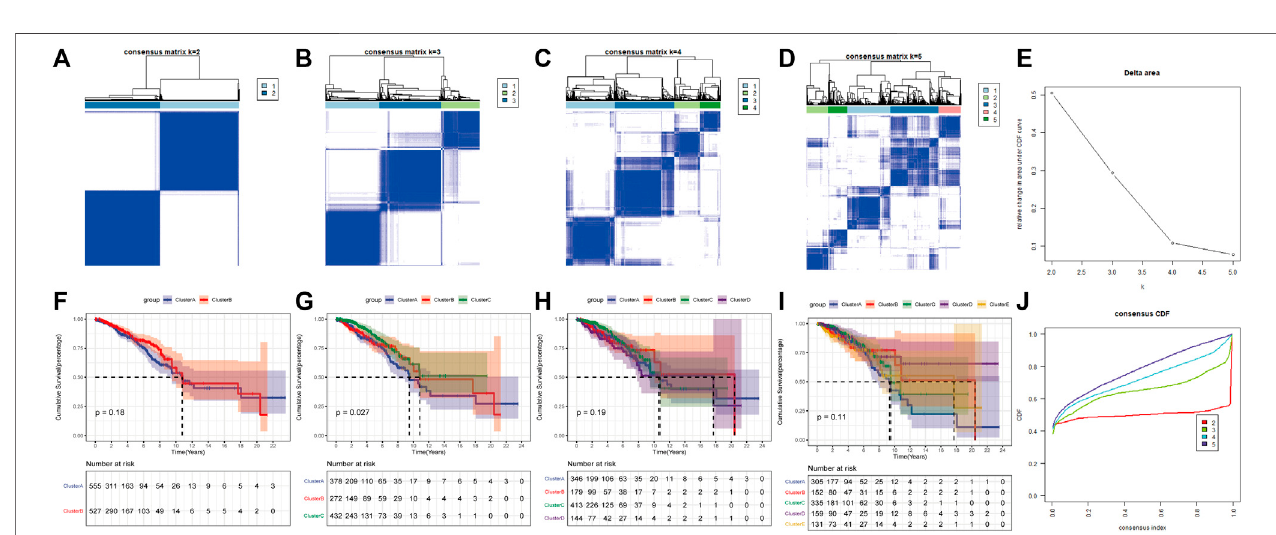
FIGURE 3 | Consensus clustering of pyroptosis-related regulators in Breast cancer by the k-means method. (A – D) Consensus clustering of 20 pyroptosis phenotype-relatedgenesinTGGA-BRCAcohortsandconsensusmatricesfork=2 – 5. (E) TherelativechangeareaunderCDFcurvesforK=2 – 5. (F – I) Survivalcurvefor K = 2 – 5. (J) The consensus CDF curves were shown for different k from 2 to 10.